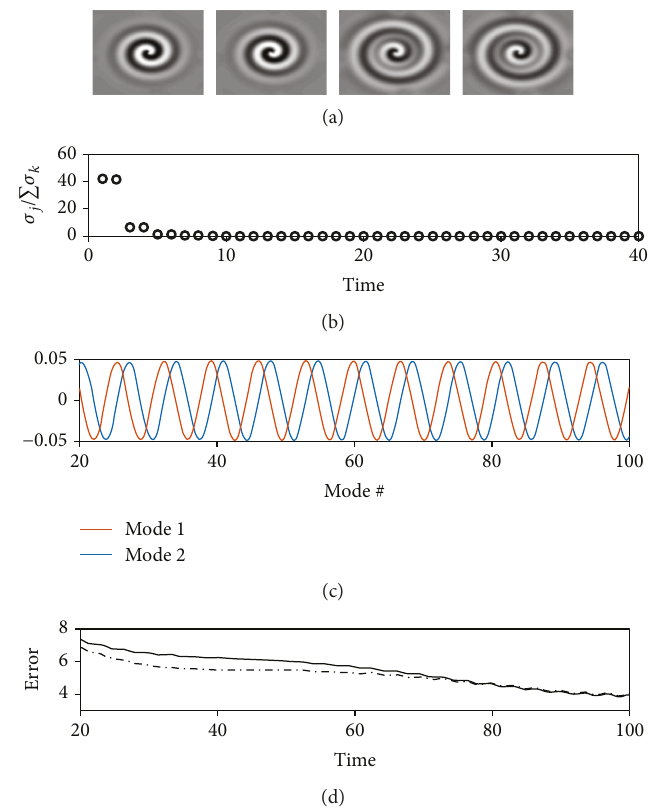
Figure 8: Diagnostic features of the reaction di ff usion system (41a) and (41b) with β = 1 and D = 0 1 . (a) The fi rst four POD modes from sampling snapshots of the spiral wave dynamics. For this data, the snapshots were collected once the spiral wave was formed. Additionally, a spatial fi lter of the form f x , y = exp − 0 01 x 2 + y 2 was applied in order to remove the e ff ects of the periodic boundary conditions on the dynamics. (b) There is a two-mode dominance in the dynamics. (c) The temporal dynamics of the fi rst two POD modes, which are extracted from the columns of the V matrix of the SVD. For the spiral waves, these temporal modes are nearly perfect sinusoids. (d) A comparison of the error between the DMD reconstruction (solid line) and reaction-di ff usion-inspired observable g (dash-dot line). Note that there is very little di ff erence in the reconstruction error in contrast to the NLS and CQGLE examples. The simulation was performed over t ∈ 0,100 with 1001 equally spaced snapshots taken. The domain was discretized with n = 128 points on the domains x ∈ − 20, 20 and y ∈ − 20, 20